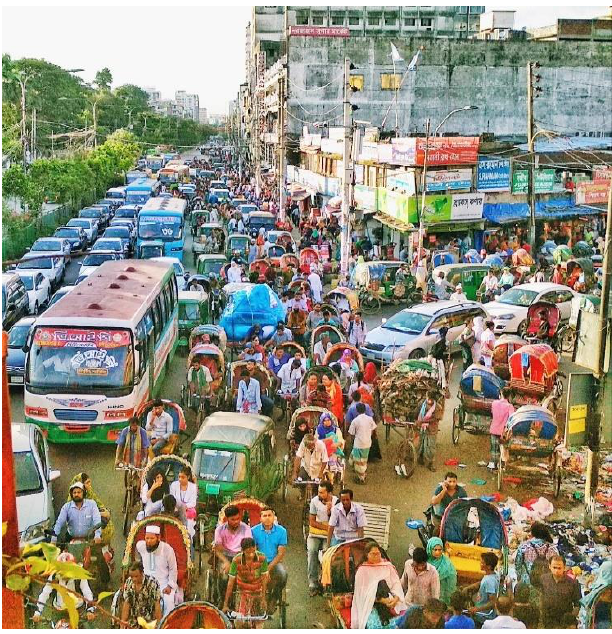
Figure 1. A typical traffic jam in Dhaka. The mixture of rickshaws, auto-rickshaws (often called 3-wheeler CNGs), motorcycles, buses, and cars can create chaotic and unpredictable congestions. The photographed traffic congestion lasted for around 2 hours, during which the researcher was able to get out of the auto-rickshaw, go to a pedestrian overpass (elevated road crossing), take the photo, and then return to the